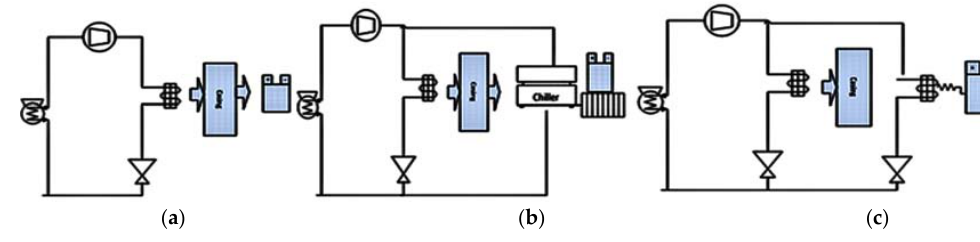
Figure 4. ( a ) Air cooling; ( b ) liquid and ( c ) refrigerant cooling [65]. The following Table 2 corresponds different aspects of a generic BTMS. Table 2. Different aspects of a battery thermal system. Table 2. Different aspects of a battery thermal